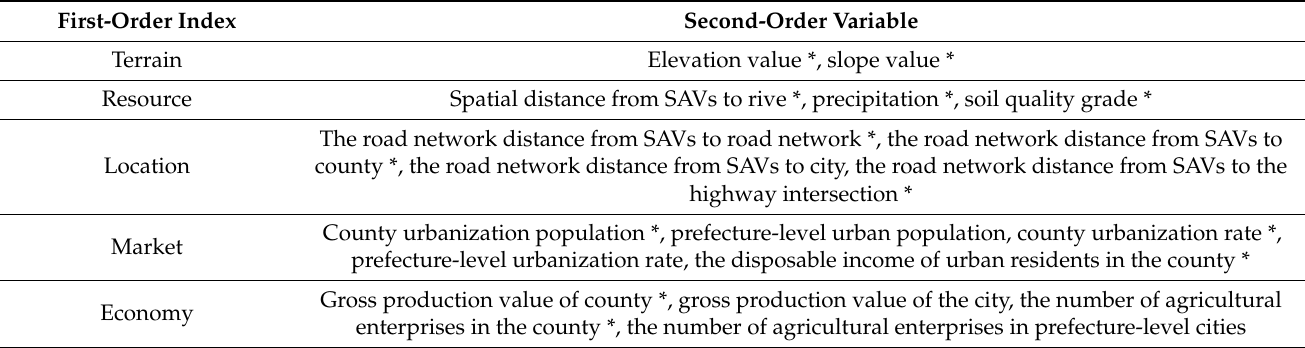
Table 2. Indices and variables accounting for SAV